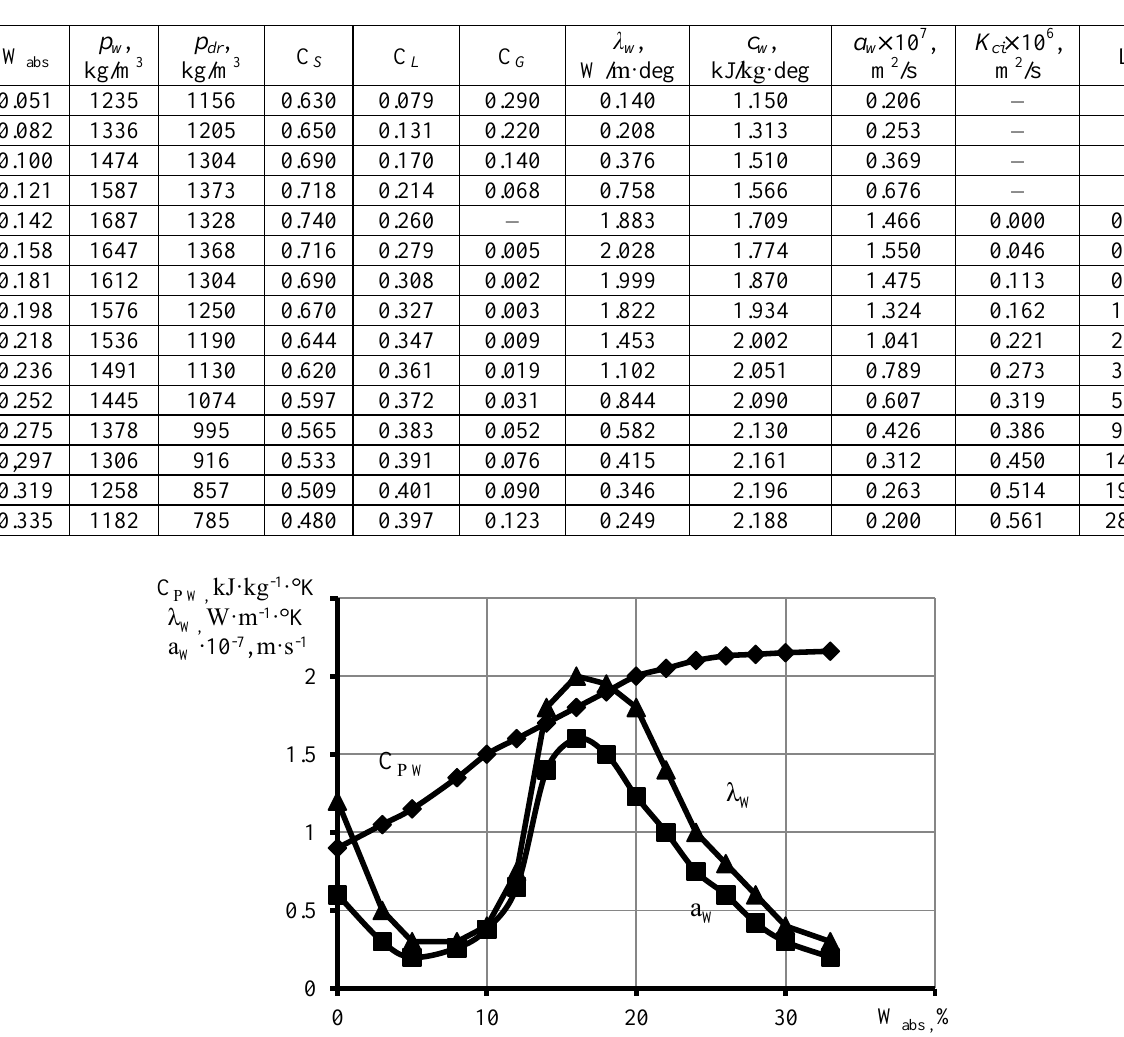
Table 4. Thermophysical properties of wet mixture